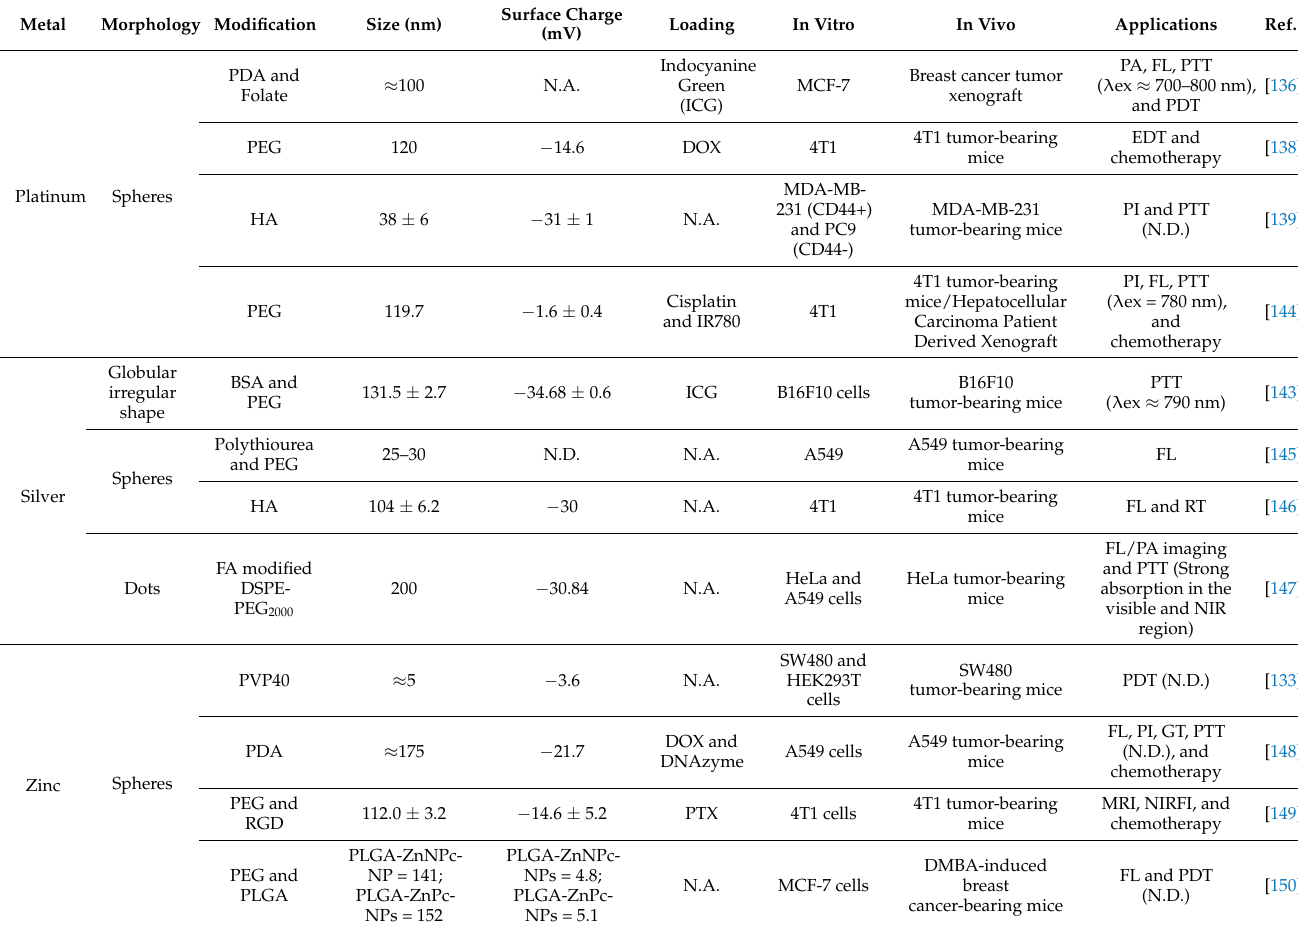
Table 4. Summary of the Platinum/Silver/Zinc-based metallic-polymer nanoconjugates/nanohybrids, their physicochemical properties, and therapeutic applications (N.D.—non disclosed, N.A.—not